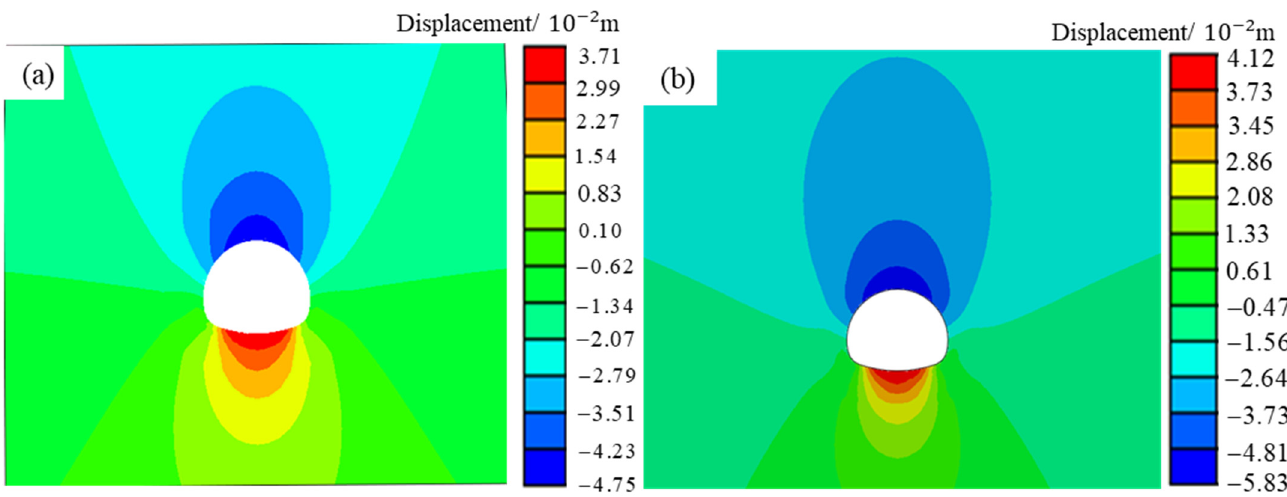
Figure 16. Vertical displacement nephogram of surrounding rock after excavation: ( a ) non-softening; ( b ) dual softening.